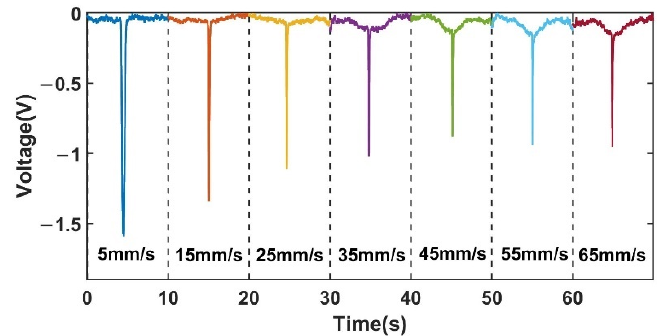
Figure 11. Comparison of signals at different velocities for 350 μ m copper.